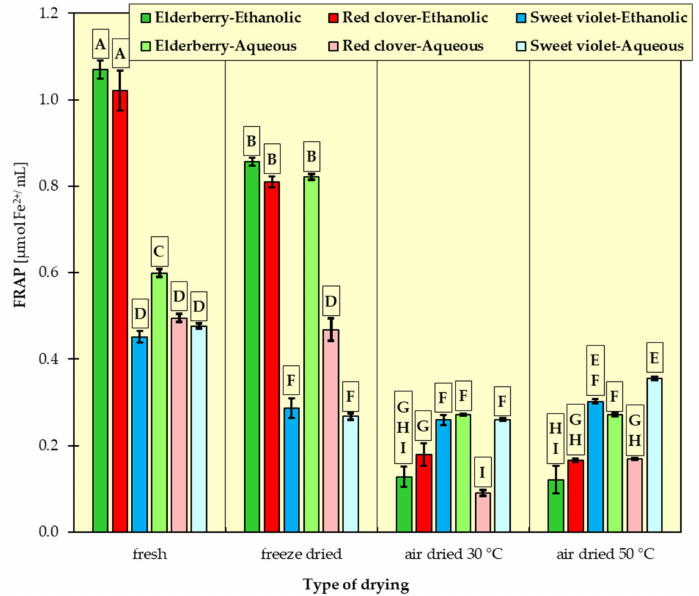
Figure 5. Antioxidant activity of ethanolic and aqueous extracts from red clover, sweet violet and elderberry flowers assessed in FRAP method. All data are expressed as mean ± SD. Bars with a different letter indicate significant differences according to HDS Tukey’s test ( p < 0.05 was accepted as statistically significant). Homogeneous groups are marked with the same